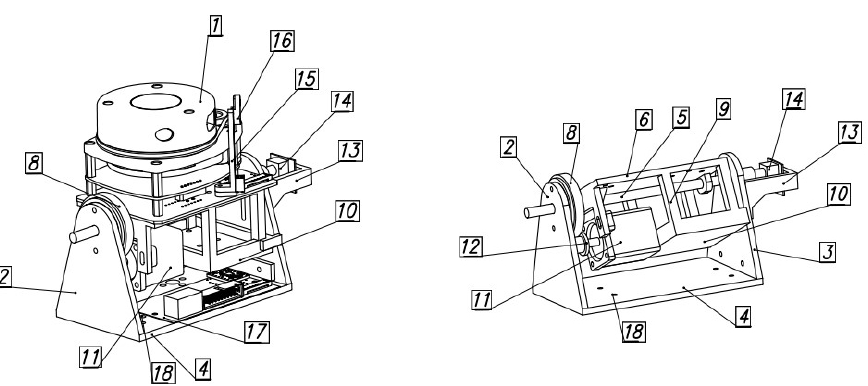
Figure 1. Scheme of the scanning mechanism: 1—scanner, 2—right bracket, 3—left bracket, 4—base, 5—shaft, 6—platform, 7—first fastening hole, 8—idler gear, 9—support, 10—shelf, 11—motor, 12—movable gear, 13—first arm, 14—rotation sensor, 15—second arm, 16—detector, 17—electrical board, 18—second fastening hole.